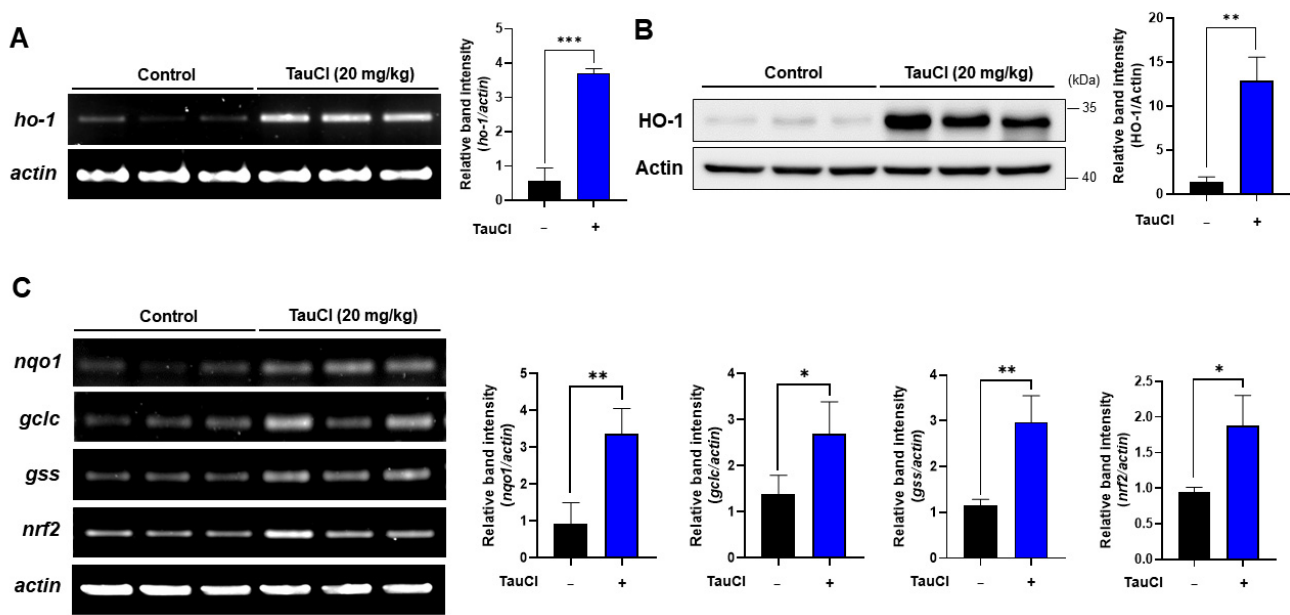
Figure 6. Upregulation of antioxidant signaling molecules induced by TauCl administration in mouse colon. The expression of ho-1 ( A ) and its protein product ( B ) was determined by RT-PCR and Western blot analysis, respectively. ( C ) Expression of other antioxidant genes and nrf2 was measured by RT-PCR. * , ** , *** Significantly different between groups compared (* p < 0.05; ** p < 0.01; *** p < 0.001).